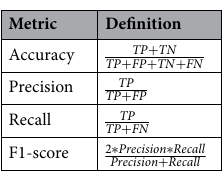
Table 1. Definitions for the four performance metrics used for model evaluation.